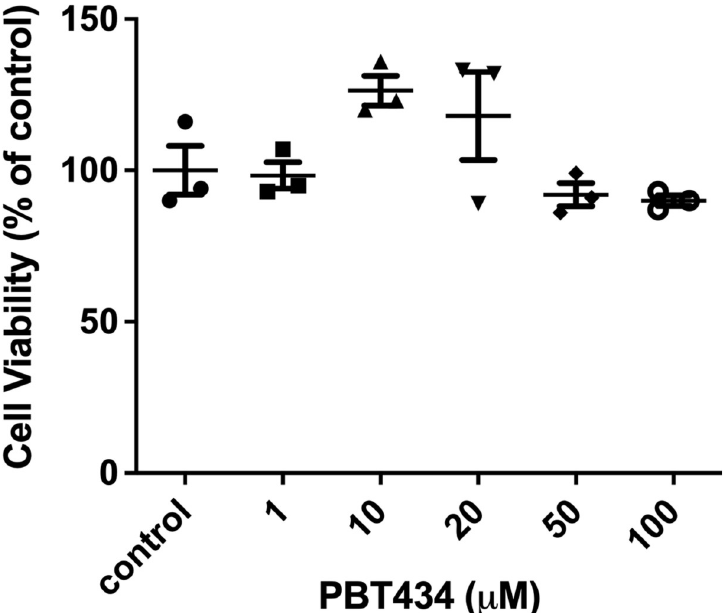
Fig 2. PBT434 toxicity in brain microvascular endothelial cells. hBMVEC were incubated with increasing concentrations of PBT434 for 24h. Cell viability was then assessed by standard MTT assay that interrogates physiologic mitochondrial function, using Triton-X as a positive control for cell killing. Data are represented as mean ± SEM, n = 3 biological replicates. Statistical significance was determined using Welch’s ANOVA with Dunnett’s T3 multiple comparison test compared to